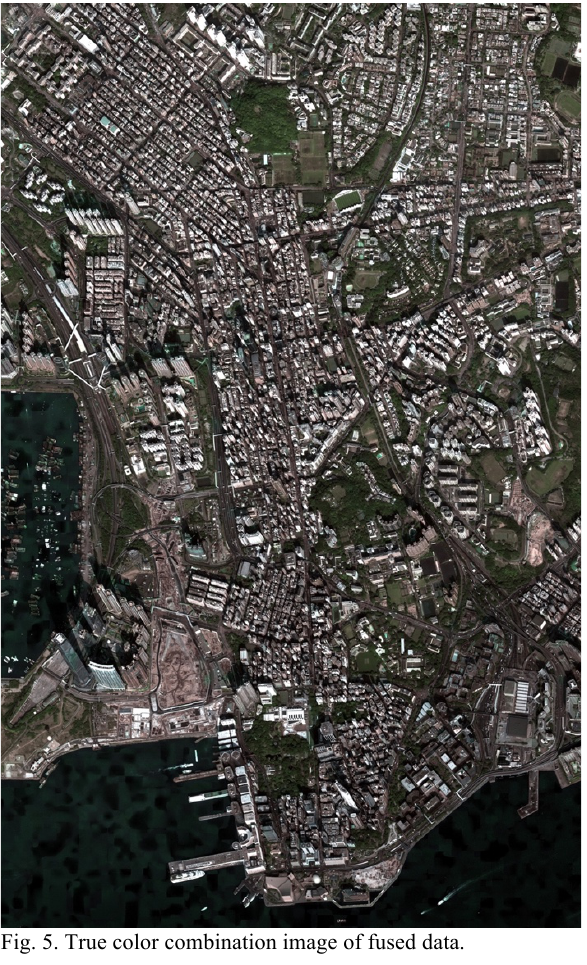
Fig. 5. True color combination image of fused data.